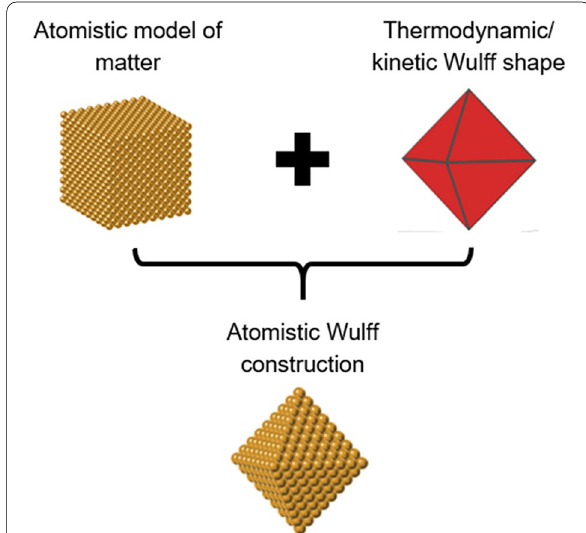
Fig. 5 Schematic of the steps required to generate an atomistic Wulff construction, here shown for a Au octahedron. The Wulff shape was rendered in Crystal Creator [32], the atomistic representation was obtained from NanoCrystal [57] and the atomistic illustrations were created in CrystalMaker